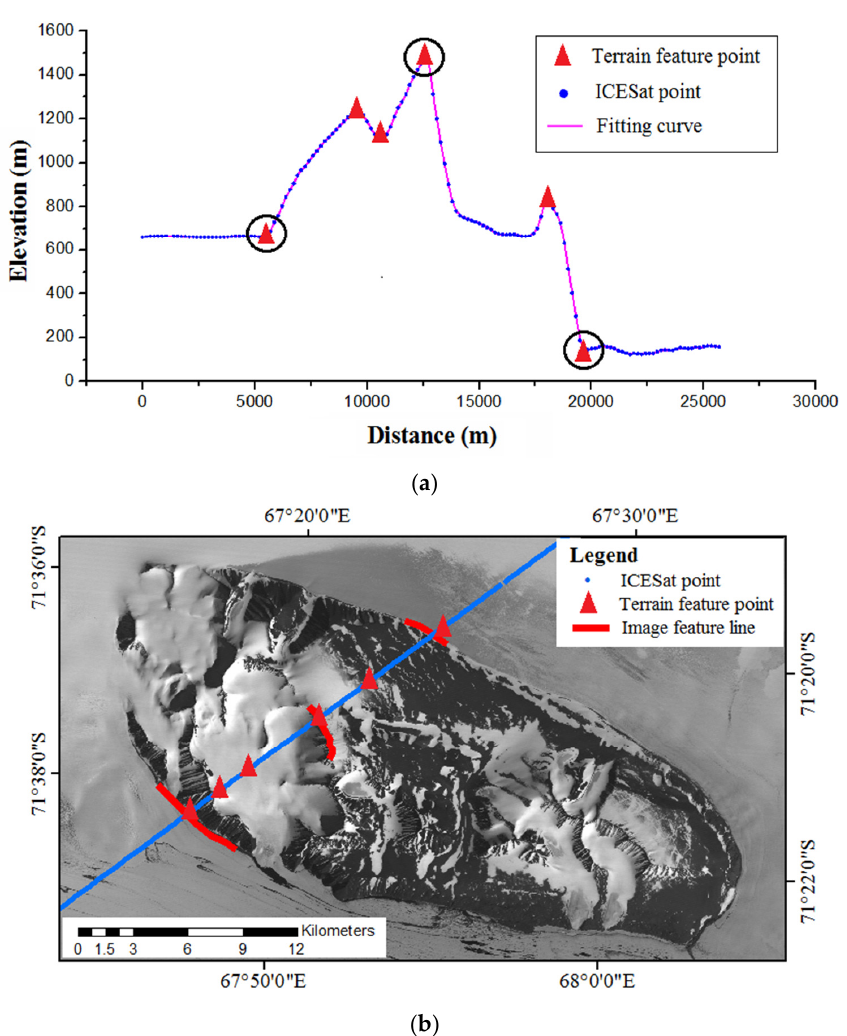
Figure 2. ( a ) Terrain feature points automatically extracted from Ice, Cloud, and land Elevation Satellite (ICESat) data, the circled points indicate that corresponding feature lines are extractable in optical image; ( b ) Corresponding terrain feature lines interactively derived from optical image.